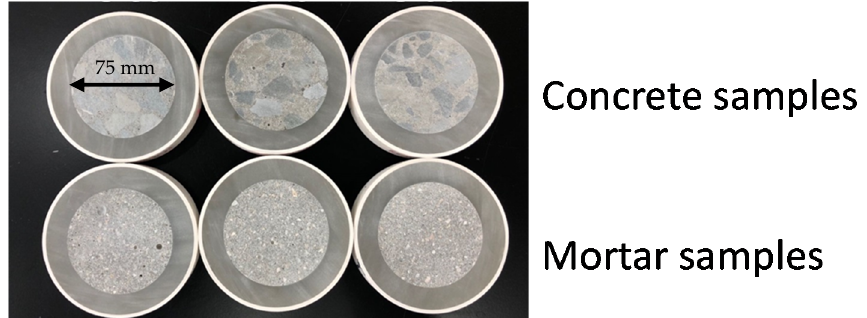
Figure 1. Slice samples.